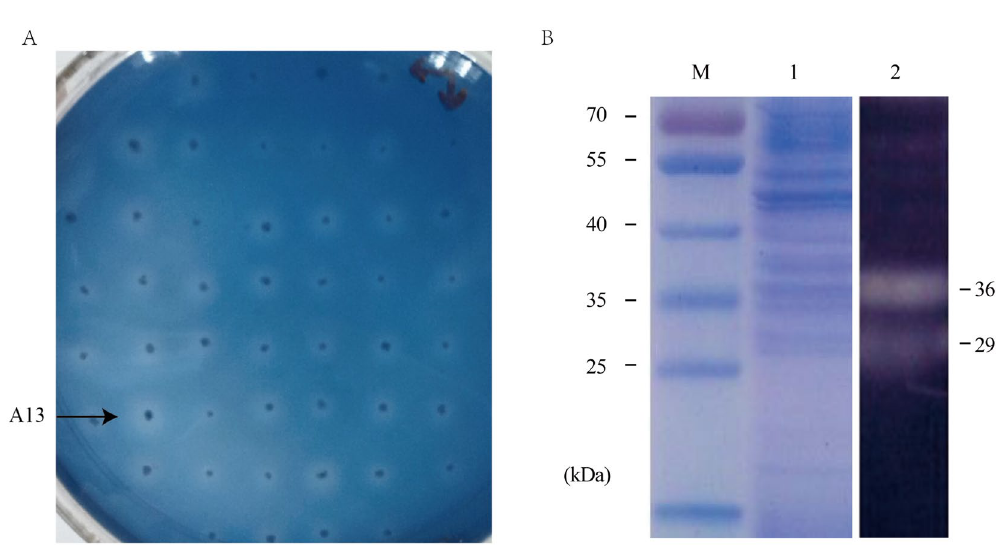
Figure 2. ( A ) Screening of S. cerevisiae transformants on SC -Ura plates containing 0.5% RBB-xylan and galactose. The S. cerevisiae transformants surrounded by varying sizes of halos indicating their expression level of xylanase were different. The plates were photographed after incubation at 28 °C for 12 h. ( B ) SDS-PAGE and zymogram analyses of XynHB derived from culture supernatants of S. cerevisiae A13. The samples were resolved on a 12% polyacrylamide gel containing 1% beechwood xylan. M, protein marker; 1 and 2, culture supernatant. The gel containing lanes M and 1 was stained with Coomassie brilliant blue. The gel containing lane 2 was obtained by